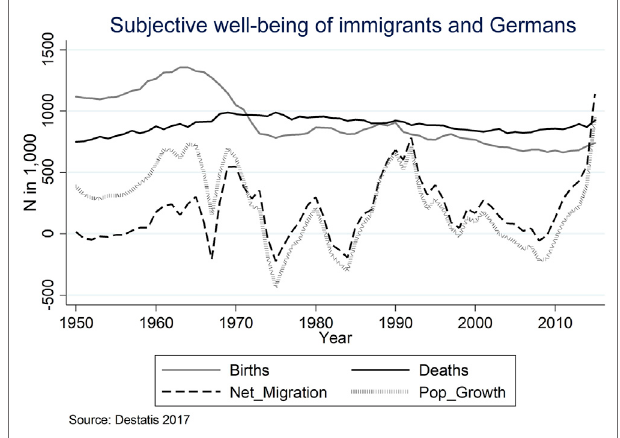
FIGURE 1 | Subjective well-being of immigrants and Germans.